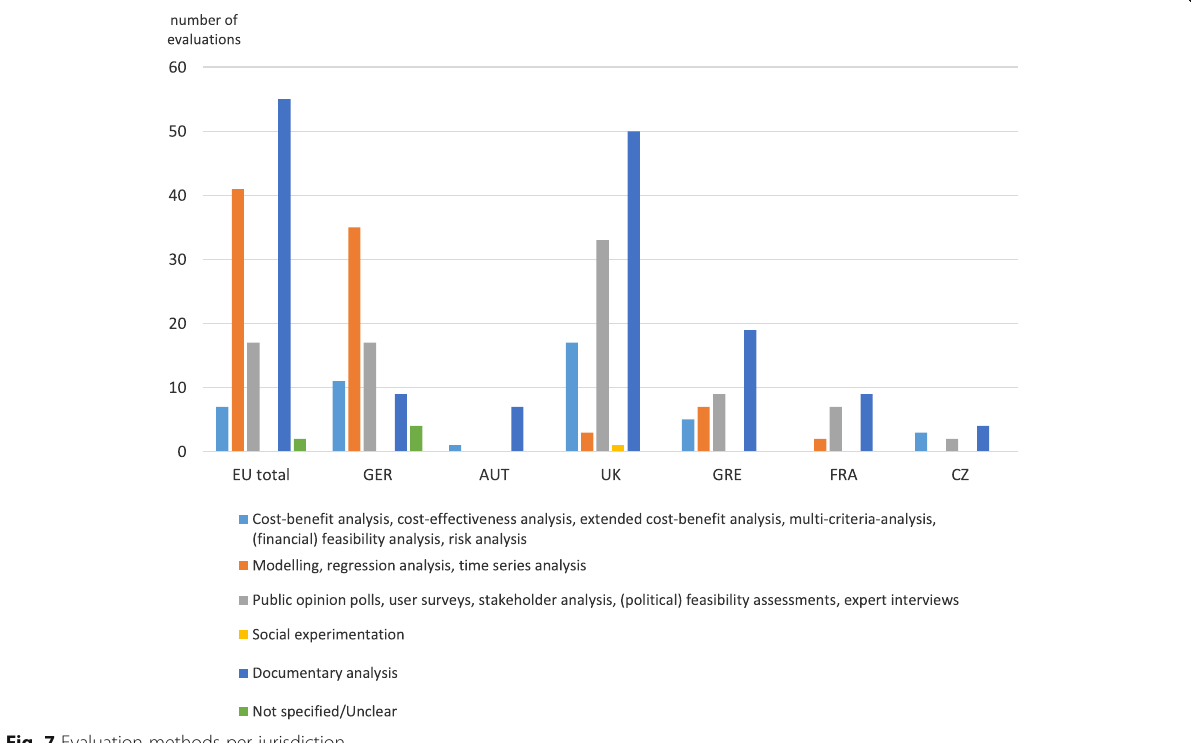
Fig. 7 Evaluation methods per jurisdiction